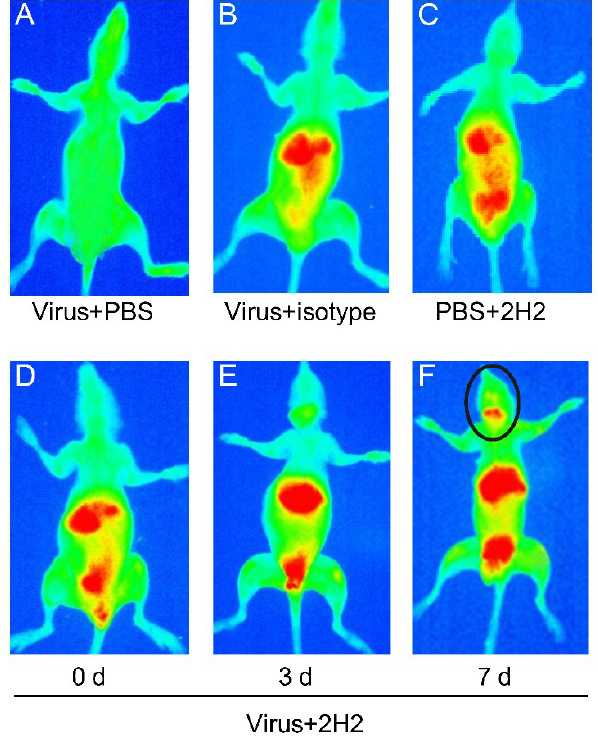
Figure 8. Reactivity of 2H2 with MED25 and the distribution in vivo . ( A ) PBS was injected after inoculation of virus served as blank for the infrared dye-labeled 2H2; ( B ) the substitution of isotype-matched antibody for the infrared dye-labeled 2H2 served as negative control; ( C ) meanwhile, PBS was substituted for virus as the control and processed parallel to the virus-inoculated group (0, 3 and 7 d); ( D – F ) Mice were injected with 2H2-infrared at 0, 3 and 7 d after virus inoculation. The red color represents the distribution of 2H2 in vivo , and the black circle marks the distribution of 2H2 in the brain stem